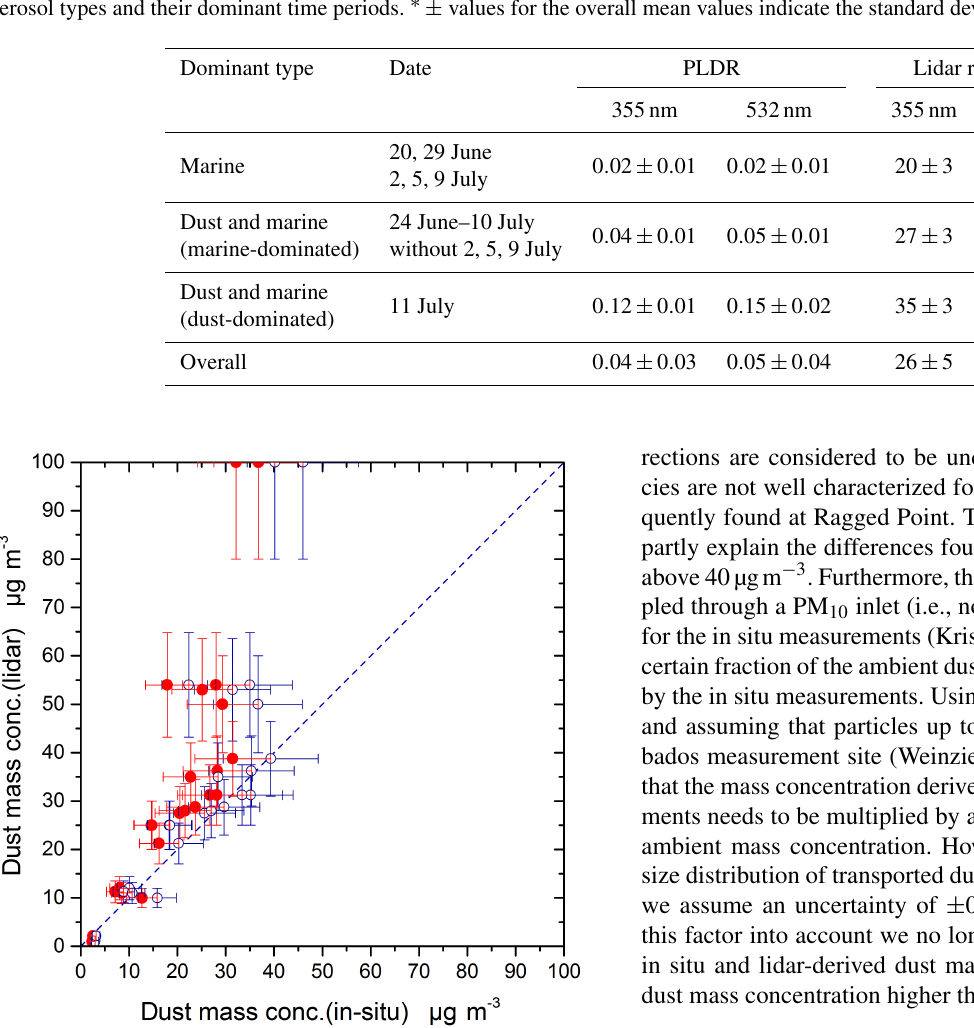
Figure 6. Dust mass concentration derived from lidar analysis vs. dust mass concentration measured in situ at Ragged Point (red dots). Only measurements that match in time (i.e., the lidar measurements were performed within or with temporal overlap to the sampling pe- riod of the in situ measurements) are plotted. Additionally the in situ vs. lidar-derived dust mass concentration is plotted including a cor- rection of the in situ measurements (multiplied by a factor of 1.25) due to the nominal cut-off of the PM 10 measurements (blue cir- cles). Error bars for the lidar-derived dust mass concentration give the systematic uncertainties resulting from measurement uncertain- ties and lidar specific input parameters. Error bars for the in situ derived dust mass concentration result from the nominal cut-off and the assumed dust mass which thus can not be covered by the in situ measurements. The dashed line gives the one-to-one